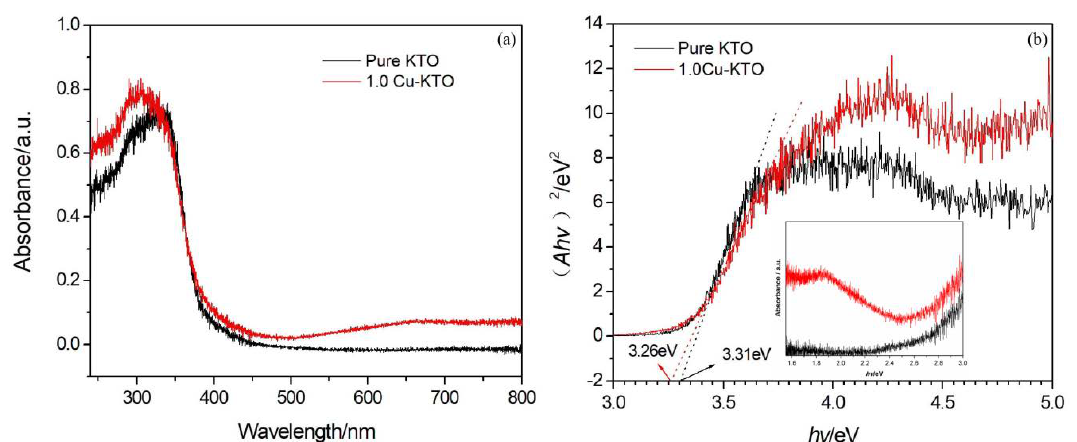
Figure 5. UV–Vis di ff use reflection spectra of KTO and 1.0 Cu–KTO ( a ) and ( Ah ν ) 2 vs. h ν ( E g ) curves from the absorption spectra to obtain band gap values ( b ).